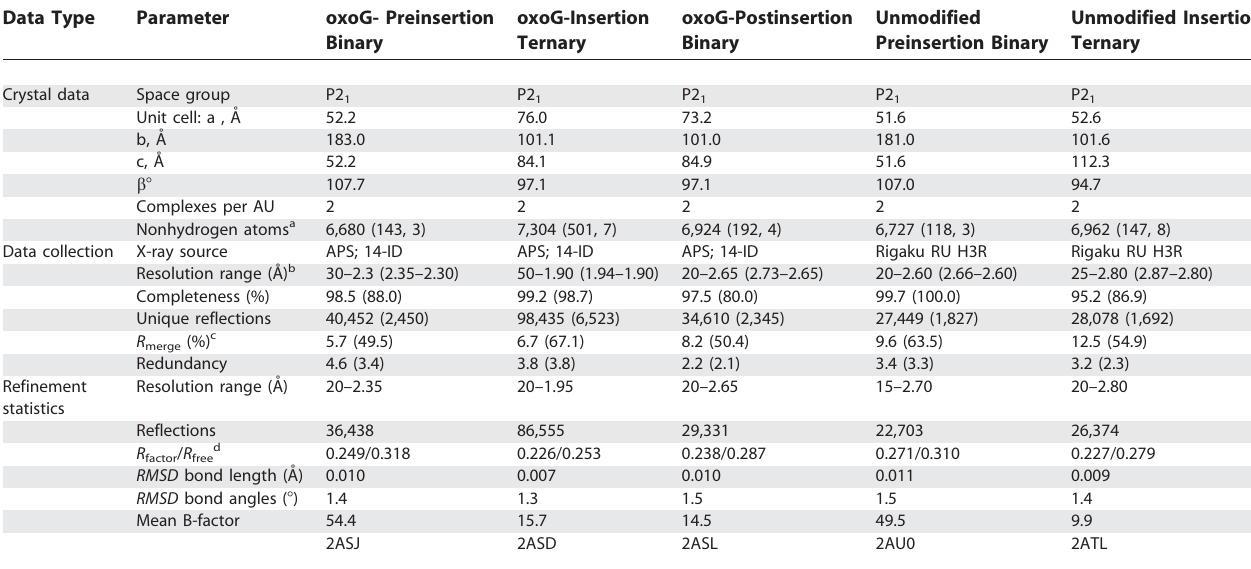
Table 2. Crystal Data, Data Collection, and Refinement Statistics Data Type